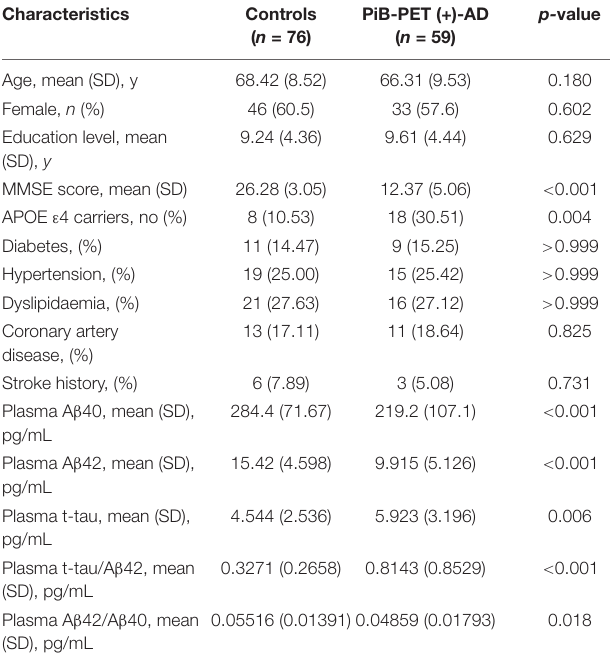
TABLE 1 | Characteristics of the participants with plasma